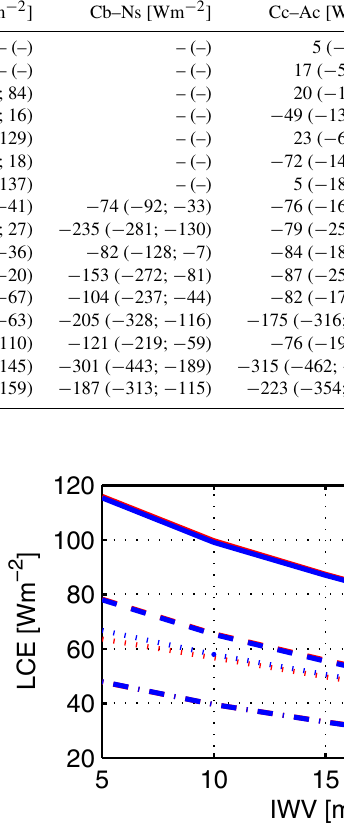
Figure 5. Dependence of the LCE on integrated water vapour (IWV) for Davos and cloud coverage of 8 oktas for low-level clouds (Sc, Cu, St–As, Cb–Ns) shown as a density plot.